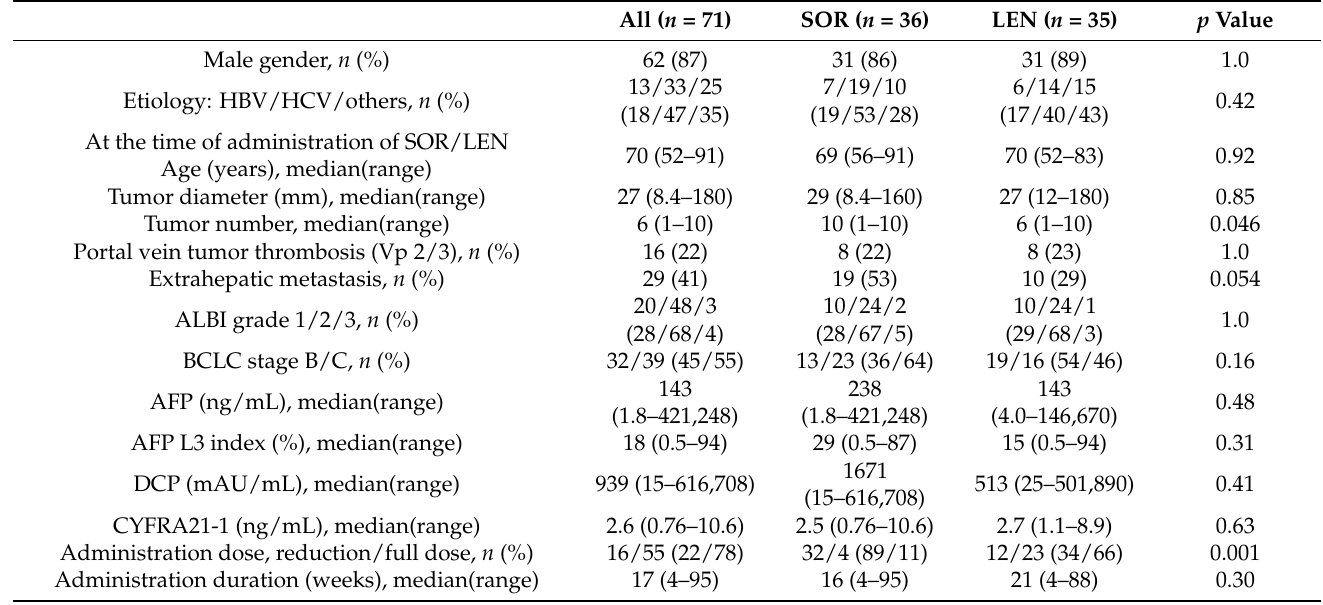
Table 1. Patient characteristics.